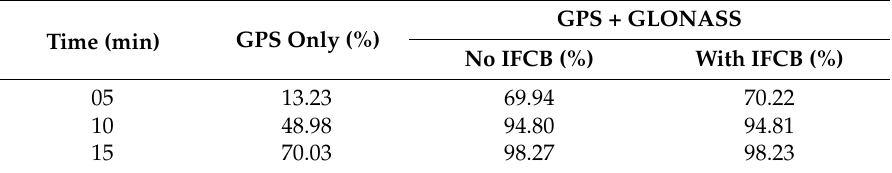
Figure 8. Fixing percentage with various observation durations for kinematic PPP with different strategies. Receivers with homogeneous type are used as rover sites. Table 2. Fixing percentage with various observation durations for kinematic PPP with different strategies.